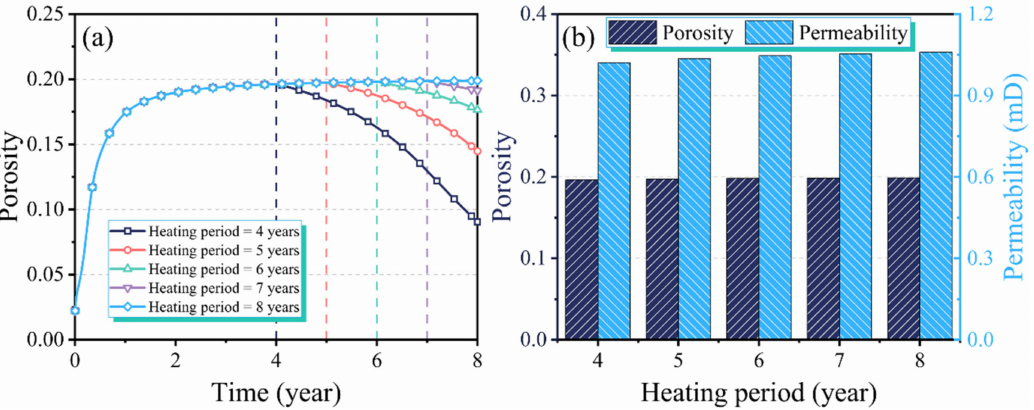
Figure 12. Porosity and permeability under different heating periods: ( a ) evolution of average unmodified porosity; ( b ) average porosity and permeability.